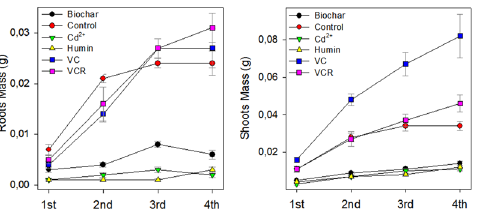
Fig 8. Root and Leaf Dry Weights of Plants Grown on Different Substrates Containing Retained Cd 2+ from the First Harvest until 28 Days after Seedling Transfer (DAT); on the x axis, 1st, 2nd, 3rd and 4th, respectively, indicate the first, second, third and fourth harvests from each experiment, conducted at seven-day intervals. Values are reported as averages ± the standard error ( n = 30